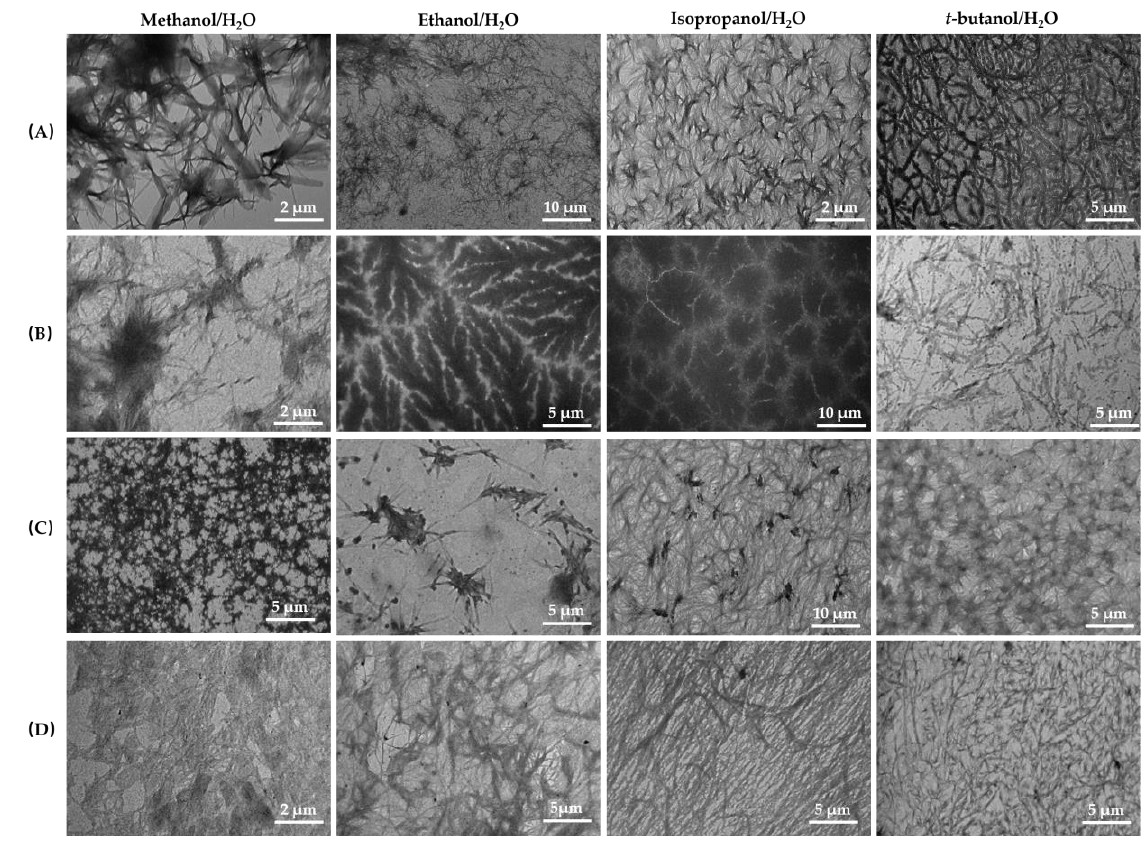
Figure 12. TEM images of dried gels formed in alcohol – water mixtures by ( A ) 2C12-Lys-Na, ( B ) 2C14-Lys-Na, ( C ) 2C12-Lys-K, and ( D ) 2C14-Lys-K.